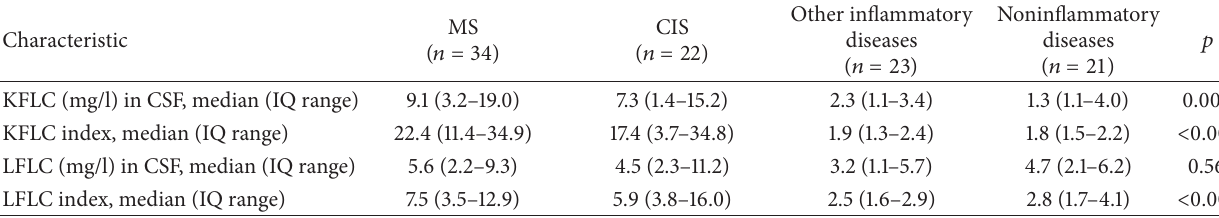
Table 4: Comparison of free light chains levels in CSF and free light chain indices in different patient